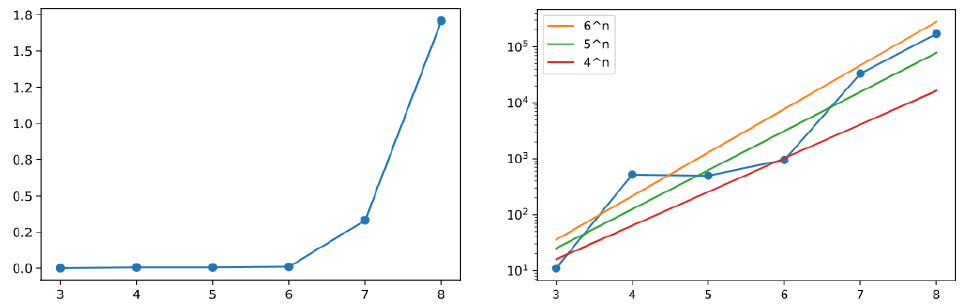
Figure 13. Amount of extra numbers proven to converge above row n , this time in a ternary tree, when it has just been finished by the Golden Automaton, in either linear or log scales